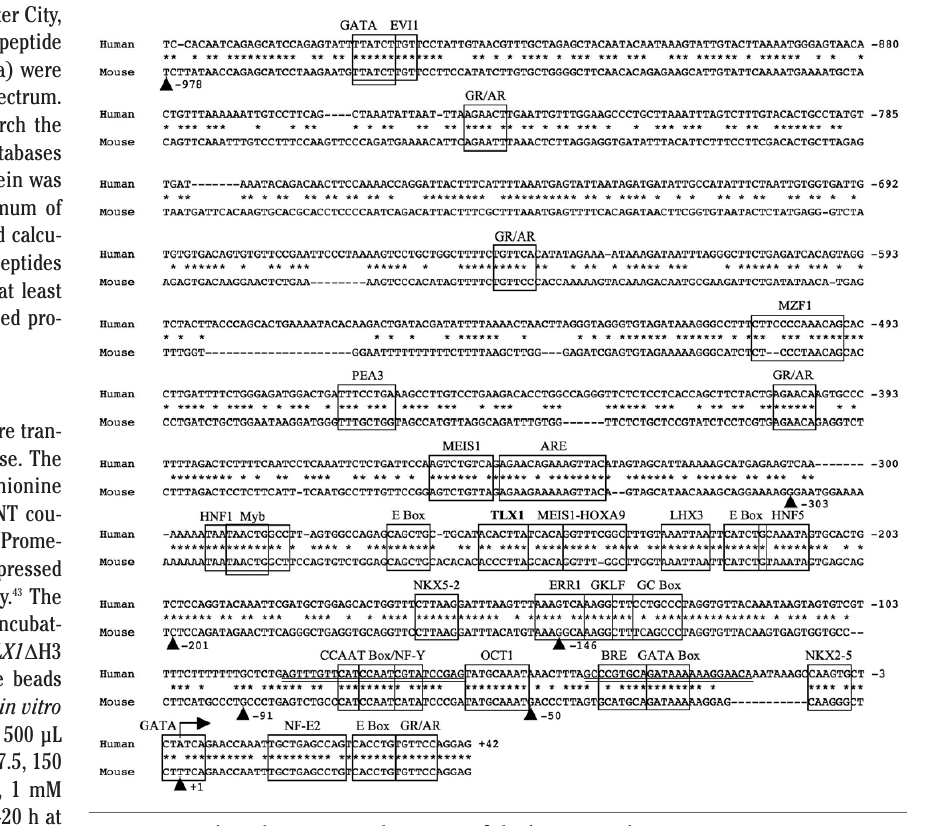
Figure 1. Nucleotide sequence alignment of the human and mouse ALDH1A1 promoters. Conserved nucleotides are marked with an asterisk. Numbers at right indicate nucleotide positions of the human sequence relative to the transcriptional start site (bent arrow). Potential regulatory elements, including a conserved TLX1 site at -257, are boxed and labeled. Solid triangles with numbers demarcate the 5’ ends of the promoter deletion con- structs used in the luciferase reporter assays. The two regions used for gel shift analysis are underlined at -85 to -60 and -42 to -19. BRE, TFIIB recognition